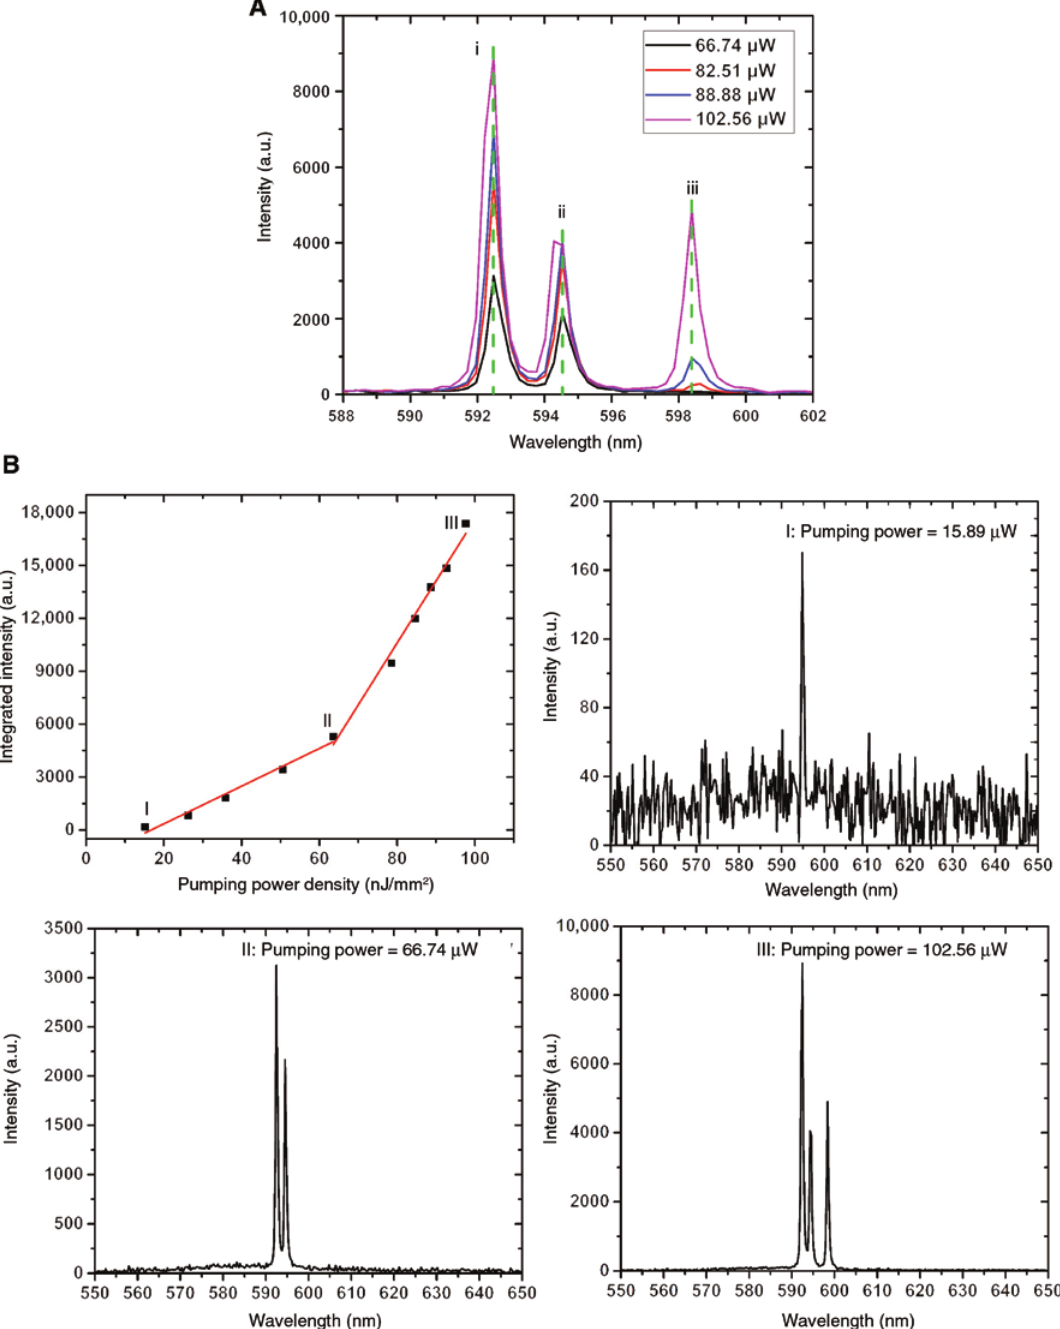
Figure 5: Slope efficiency curve of the laser and typical emission spectra under various pumping powers when 4 mmol/l RHB solution is used. (A) Typical laser emission spectra recorded under different pumping powers when the RHB concentration is 4 mmol/l. (B) Relationship between the integrated laser emission intensity and pumping power, and spectra recorded under various pumping